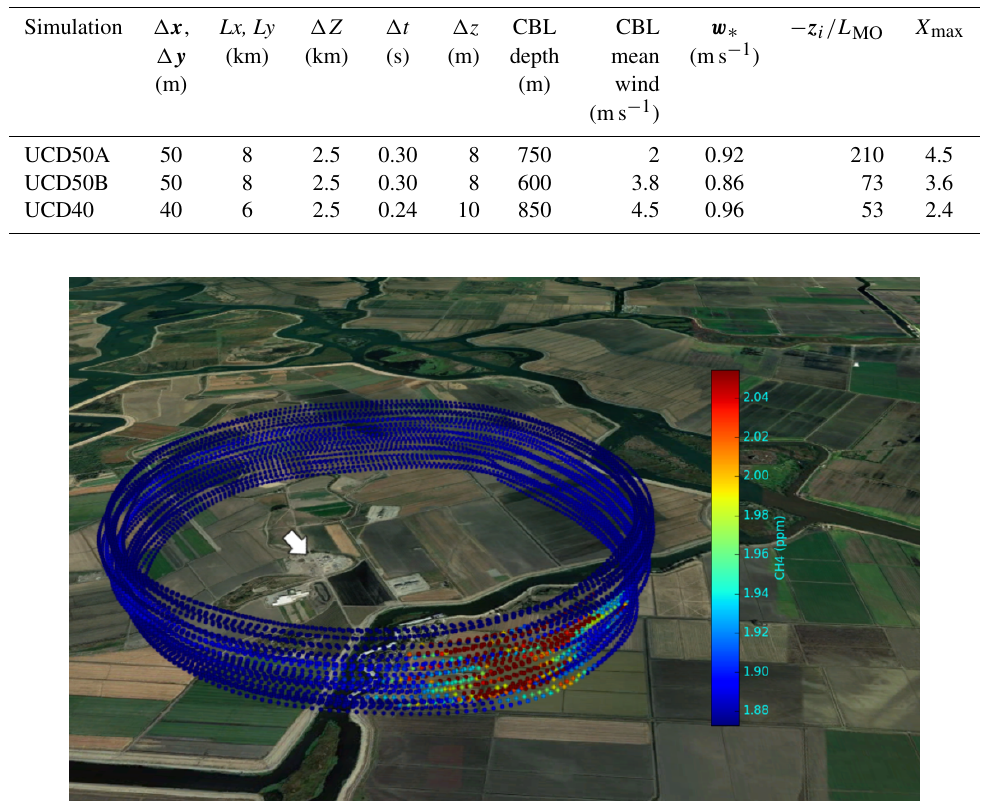
Table 1. Domain and micrometeorological parameters for the three WRF-LES experiments in this study. L represents the Monin–Obukhov length.